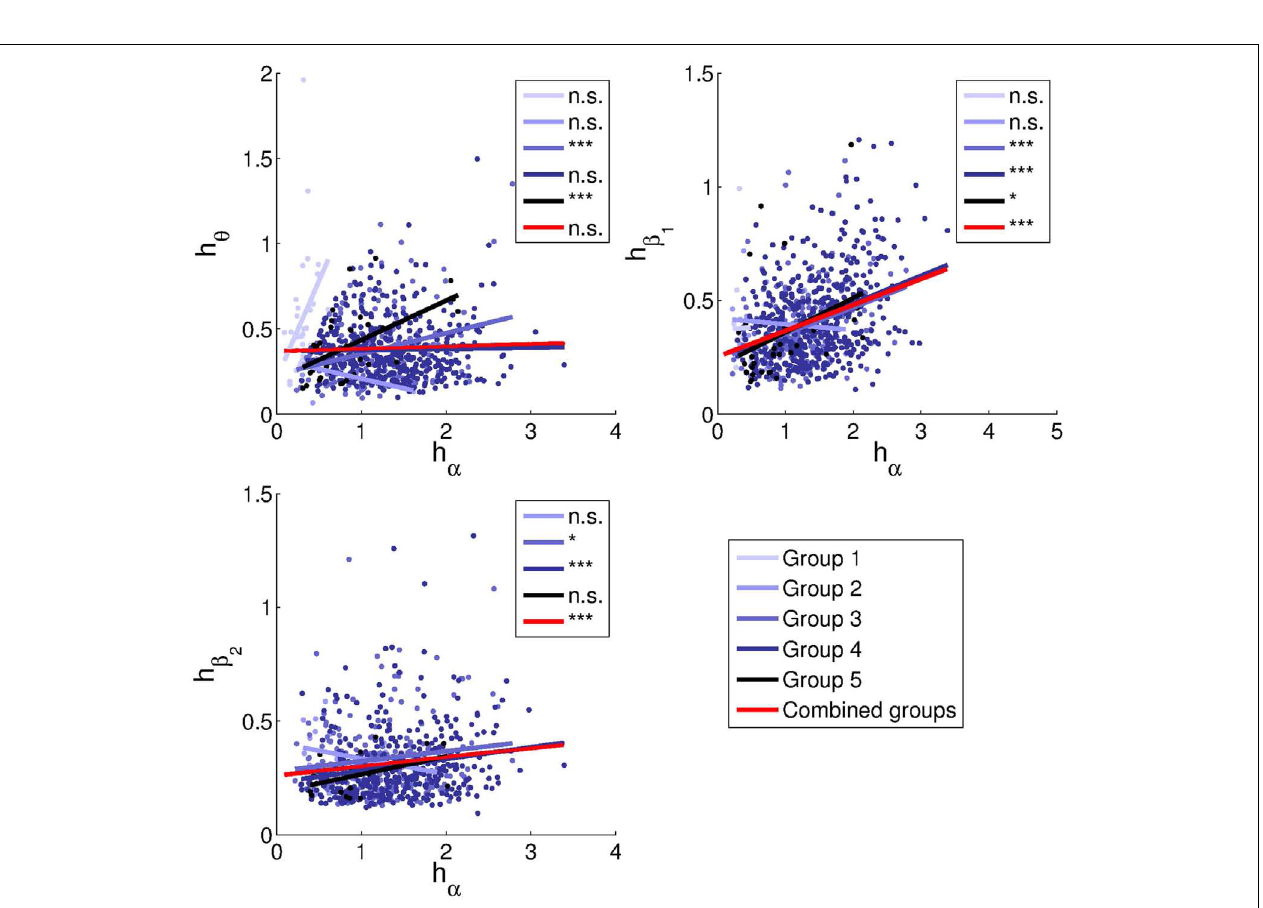
identified for Group 1. Correlation coefficients and parameters of the fits are listed in Table 2 . Significance levels: n.s. non-significant, *0.05,